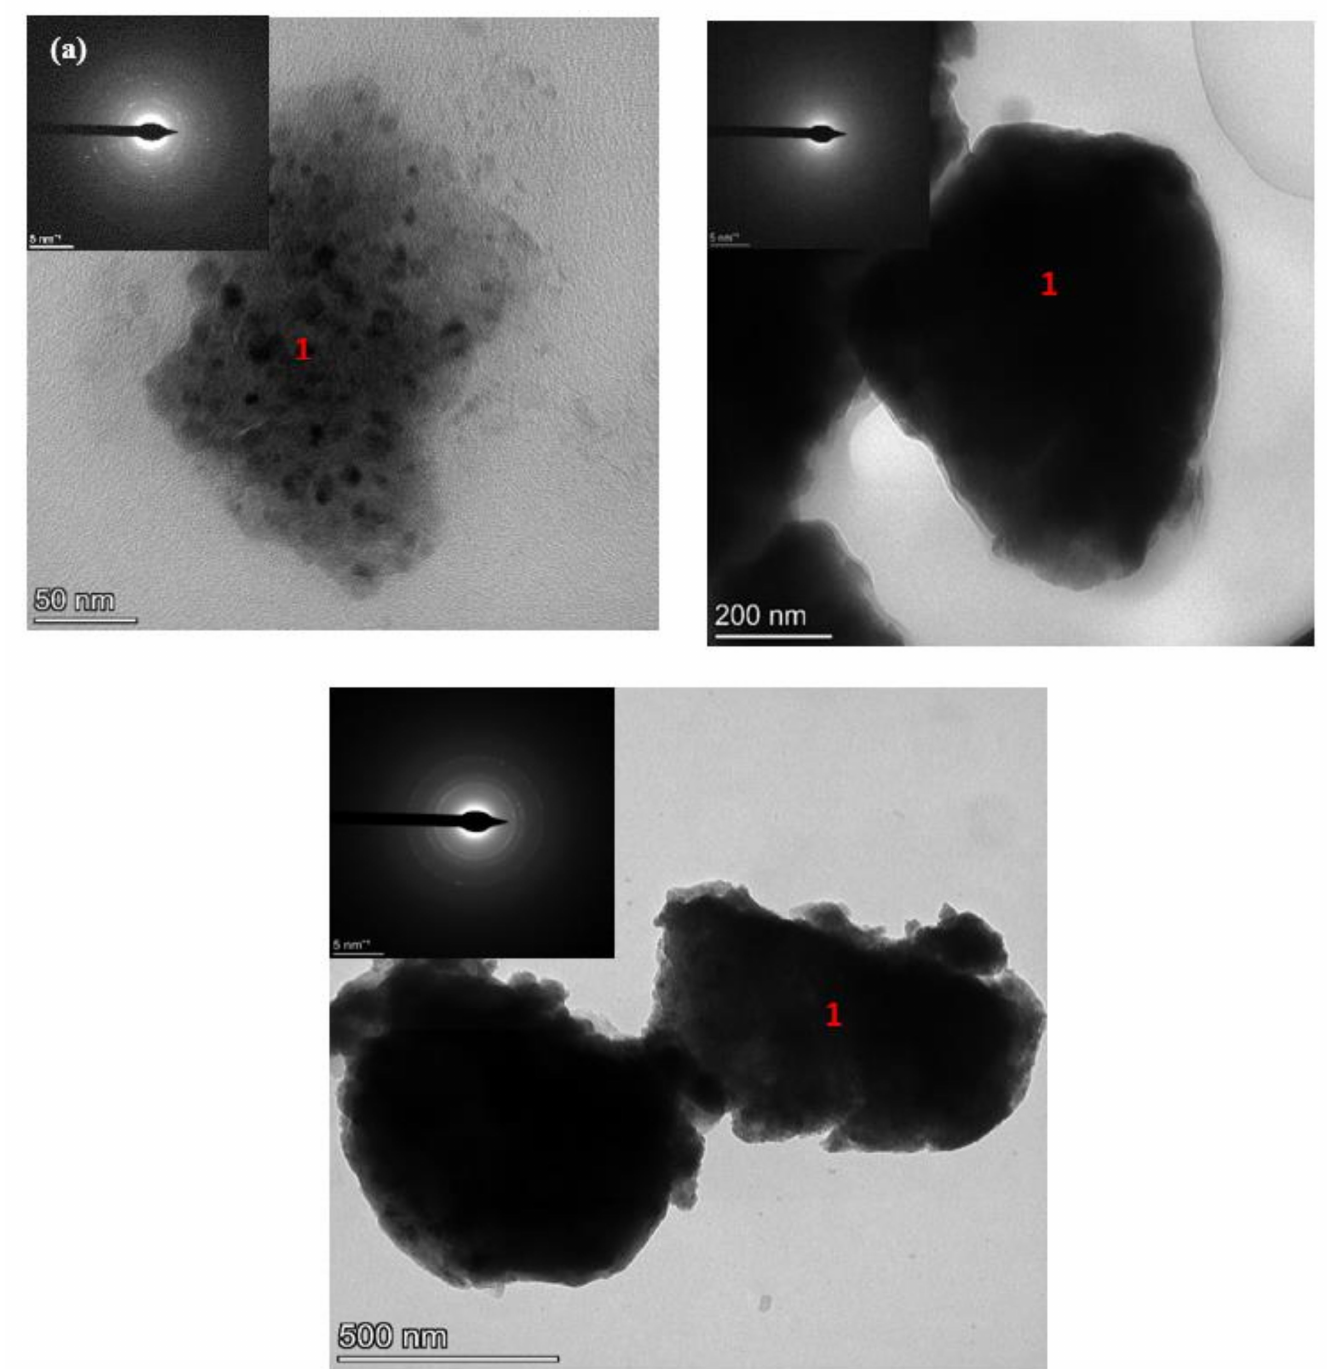
Figure 11. Bright field TEM images of a cluster of collected particles that were paired with ( a ) conventional martensitic stainless steel, ( b ) the WC-CoCr coating, and ( c ) the WC-FeCrAlY coat- ing. The inset in each Figure shows the SAED of each field of view. All the diffraction pattern insets have a scale of 5 nm − 1